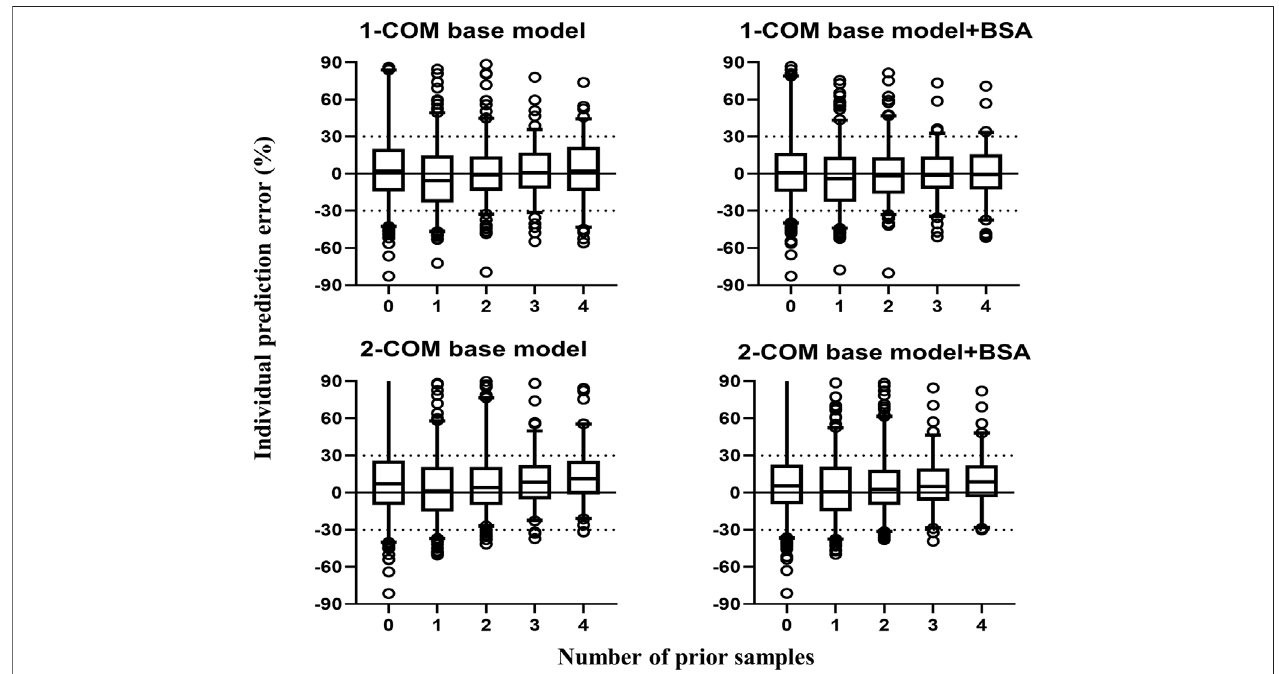
FIGURE 5 | Box plots of individual relative prediction error (IPE%) with Bayesian forecasting for two structural models with or without covariates in different scenarios(0representspredictionwithoutpriorinformationand 1-4representswithprioronetofourobservations, respectively).Inscenarion,priornobservations were used to estimate the individual prediction and it was then compared with the corresponding observation. 1-COM, one compartmental model; 2-COM, two compartmental model; BSA, body surface area.